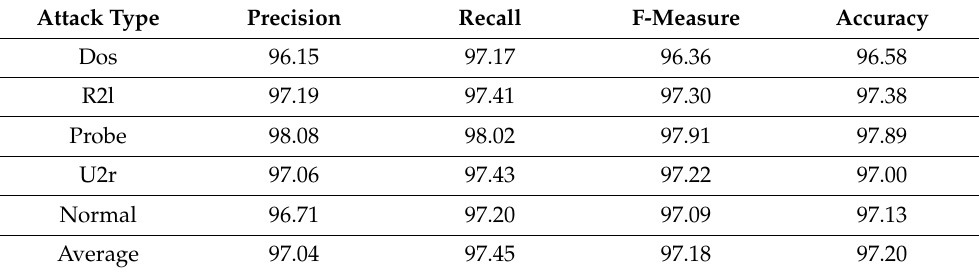
Table 5. Result Analysis of Proposed RNN-LSTM